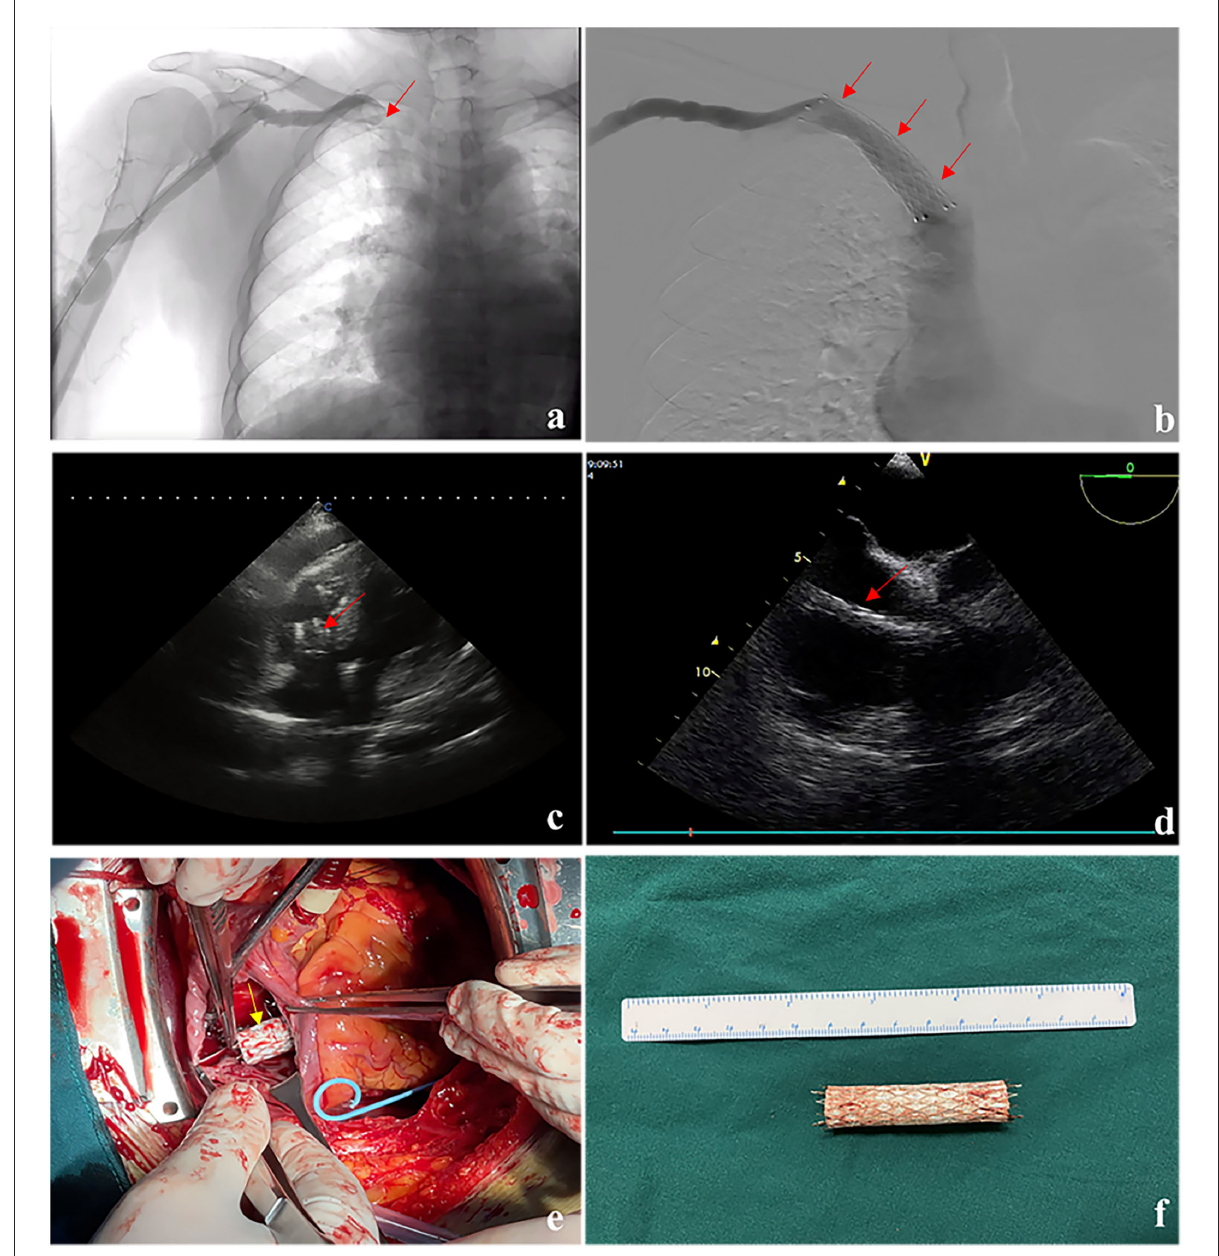
FIGURE1 Imaging data and intraoperative data of the patients: (a) stenosis (red arrow) of the confluence of the right subclavian vein and the innominate vein in a digital subtraction angiography examination, (b) stent (red arrow) placement in central vein stenosis, (c) transthoracic echocardiography showing pericardial effusion and a stent (red arrow) in the right ventricle, (d) transesophageal echocardiography indicating a segment of stent migration (red arrow) in the right ventricle, (e) the tail of the stent (yellow arrow) was found to have been inserted into the atrial wall during the operation, and (f) a retrieved covered